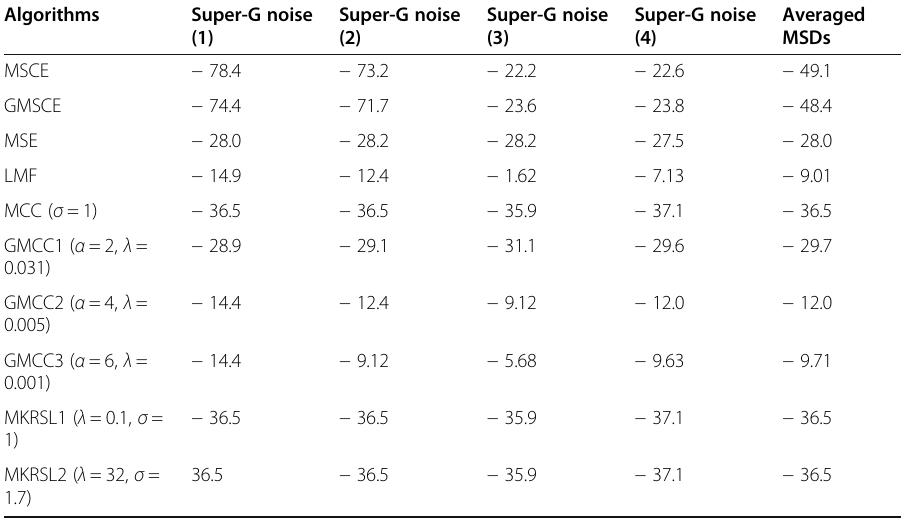
Super-G noise Super-G noise Super-G noise Averaged (1) (2) (3) (4) MSDs